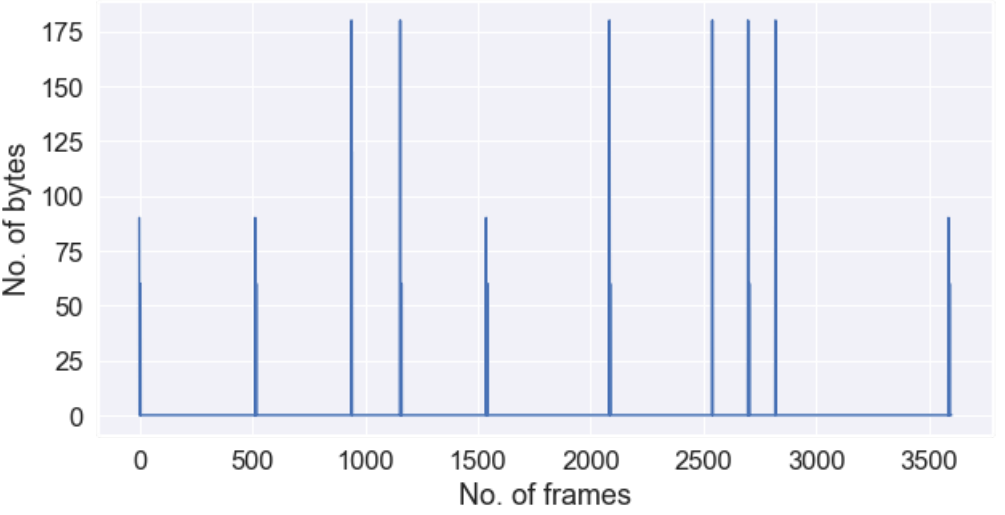
Figure 31b. Network bytes sent in